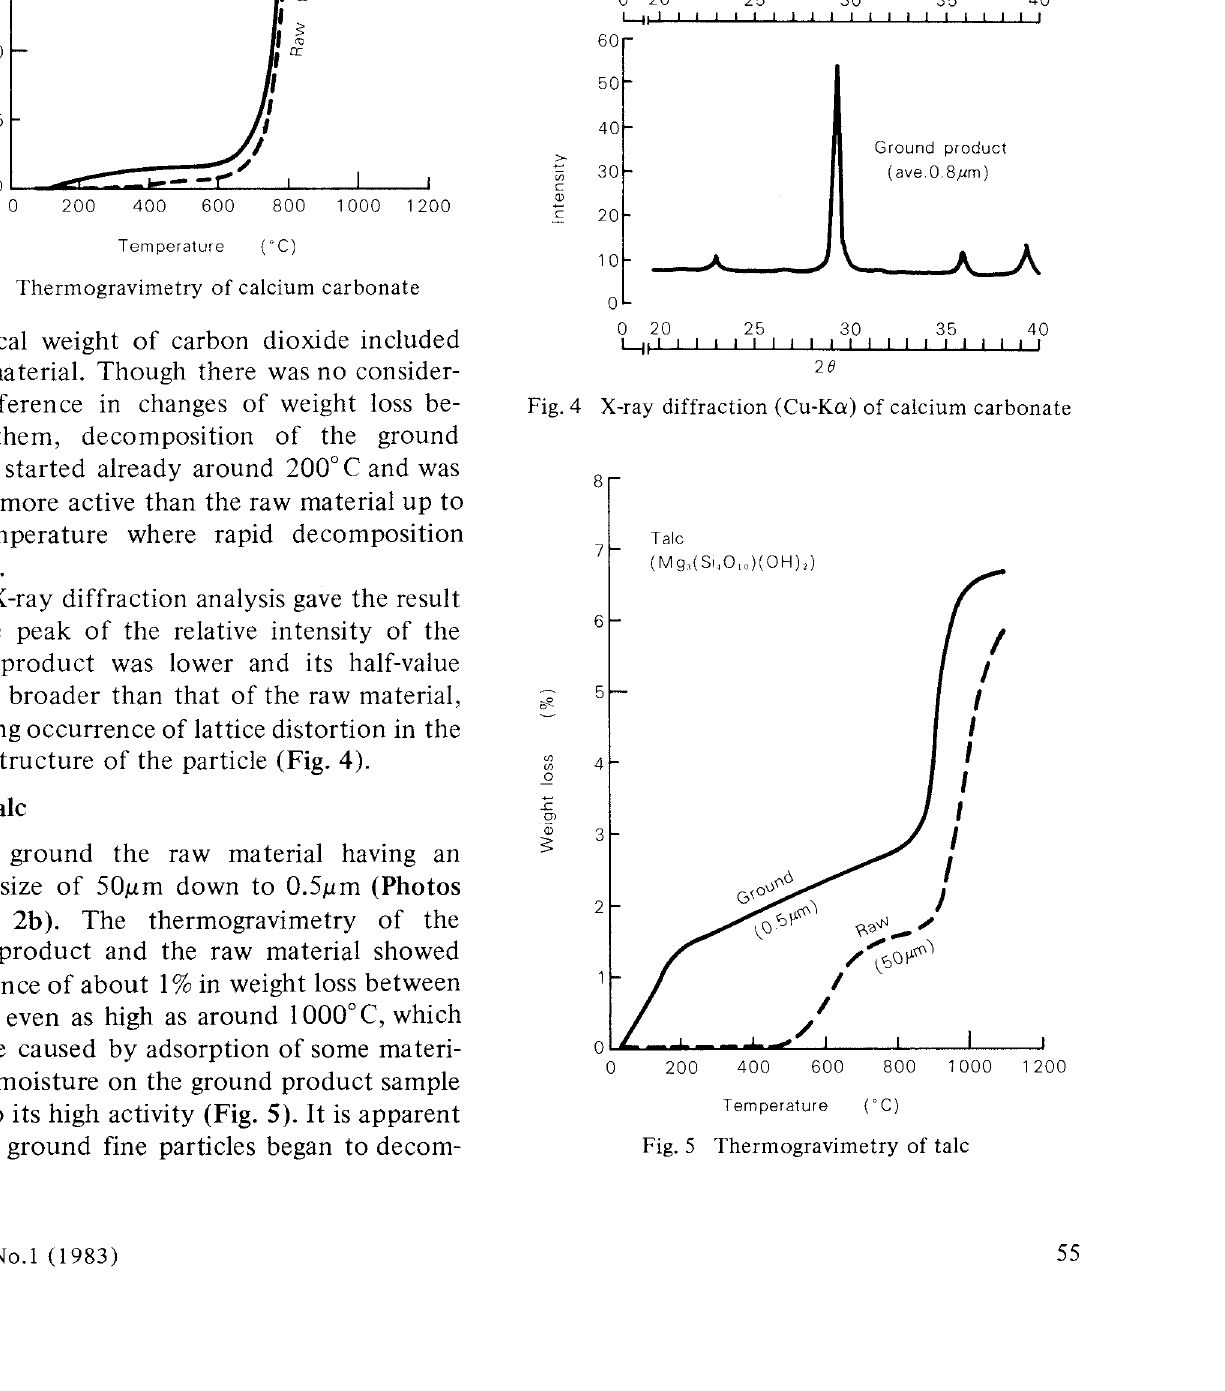
Fig. 3 Thermogravimetry of calcium carbonate